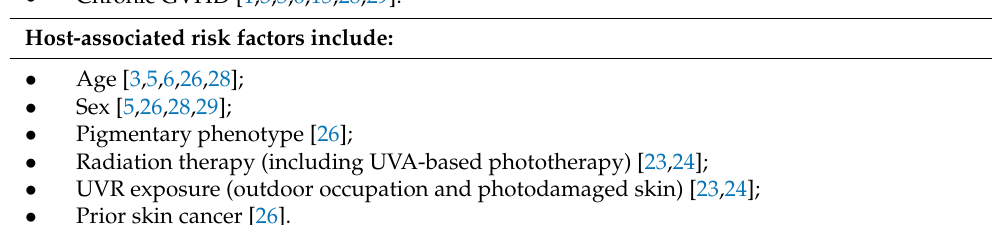
Figure 5. Squamous cell carcinoma with perineural invasion of greater than 0.1 mm.